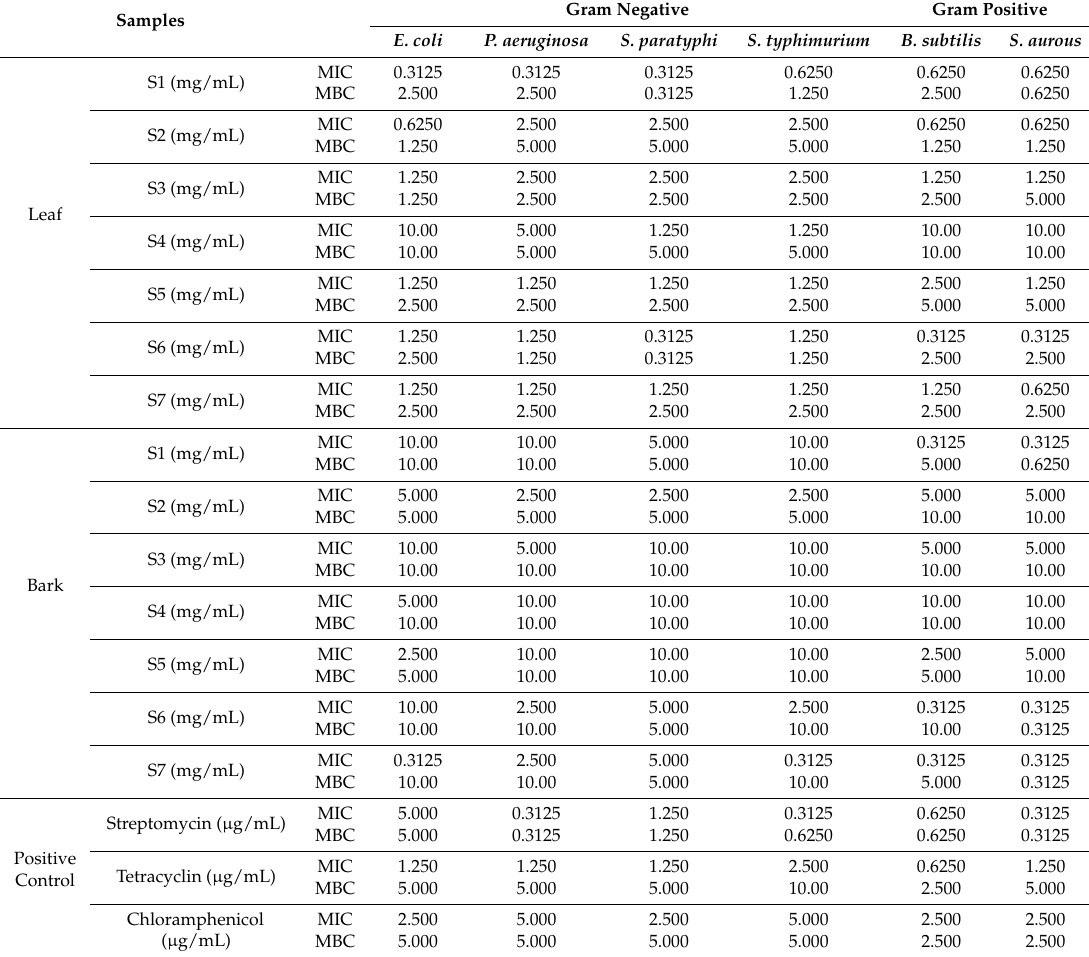
Table 5. MIC and MBC values of leaf and bark extracts of different E. ulmoides varieties against bacteria.